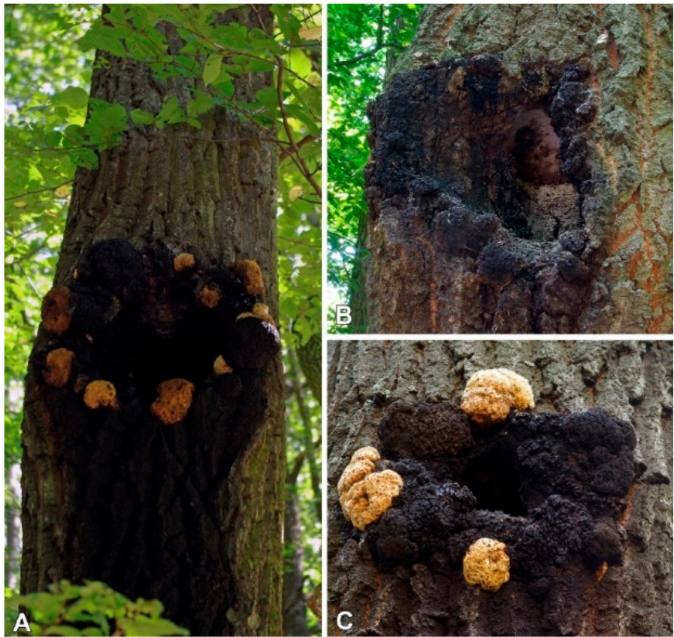
Figure 1. Basidocarp and the imperfect stage (sterile conk) of Inonotus nidus-pici on living Quercus cerris in Hungary. ( A ) Young and old sterile conks of the studied specimen (PV1043); ( B ) old sterile conks and sporulating basidiocarp (Börzsöny Mts, 19. Jun 2021; ( C ) young and old sterile conks (Visegr á d Mts, 1 October 2011). Photos: V.